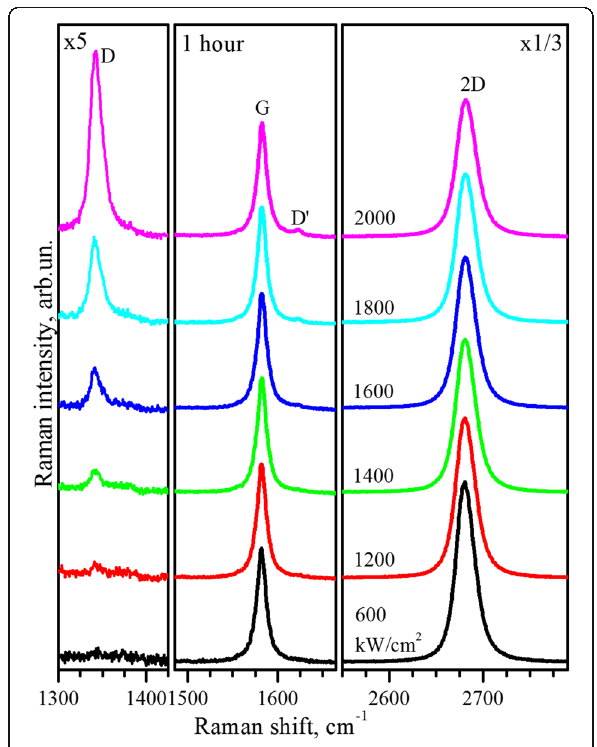
Fig. 3 Raman spectra. Raman spectra of the single-layer graphene sequentially exposed during 1 h with varied power of 488-nm laser line. Spectra are normalized to the intensity of their G bands